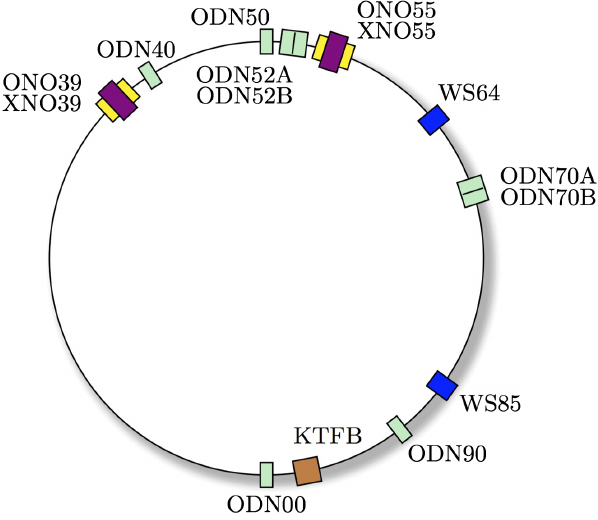
FIG. 1. Sketch of the PS ring with the key elements of MTE, i.e., sextupole (called “ X ” ) and octupole (called “ O ” ) magnets. “ ON ” octupoles are used to generate and manipulate the islands, whereas “ OD ” octupoles are used to control the nonlinear transverse coupling. The positions of the kicker of the transverse feedback (KTFB) and of the vertical wire scanners (WS) are indicated as well.